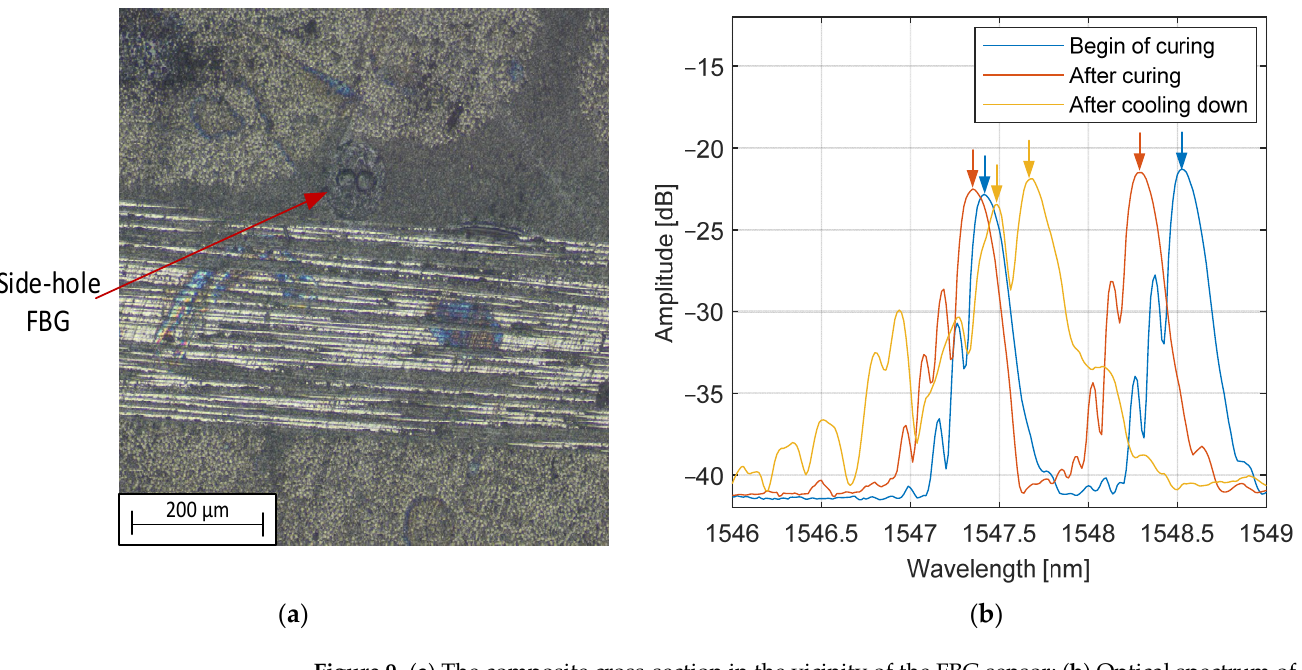
Figure 9. ( a ) The composite cross-section in the vicinity of the FBG sensor; ( b ) Optical spectrum of HB FBG before and after curing, and after cooling down.